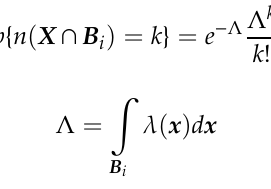
Figure 3. The homogeneous Poisson point process (left) and the inhomogeneous Poisson point process (right).